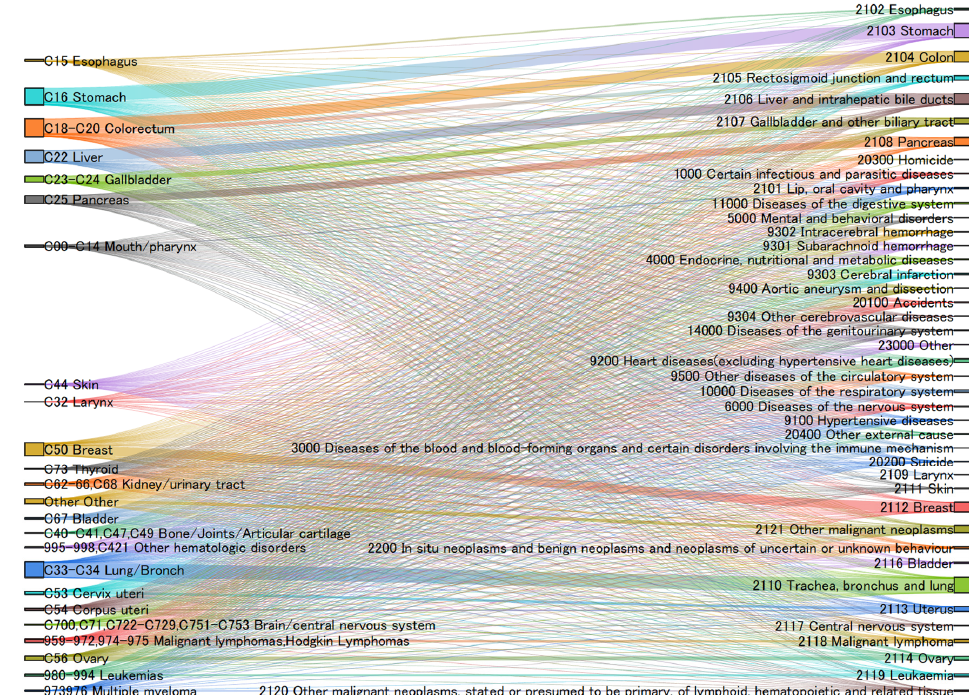
Figure A1. Relationships between cancer sites and cause of death (male patients).